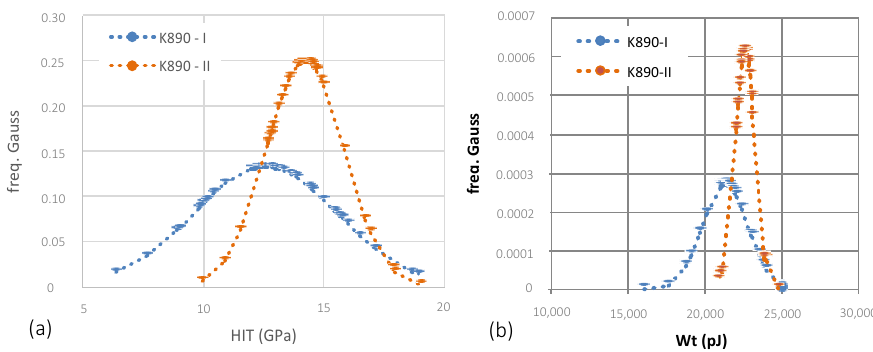
Figure 9. Nanoindentation load (Fn) vs. penetration (Pd) curves of K890-I and K890-II samples.